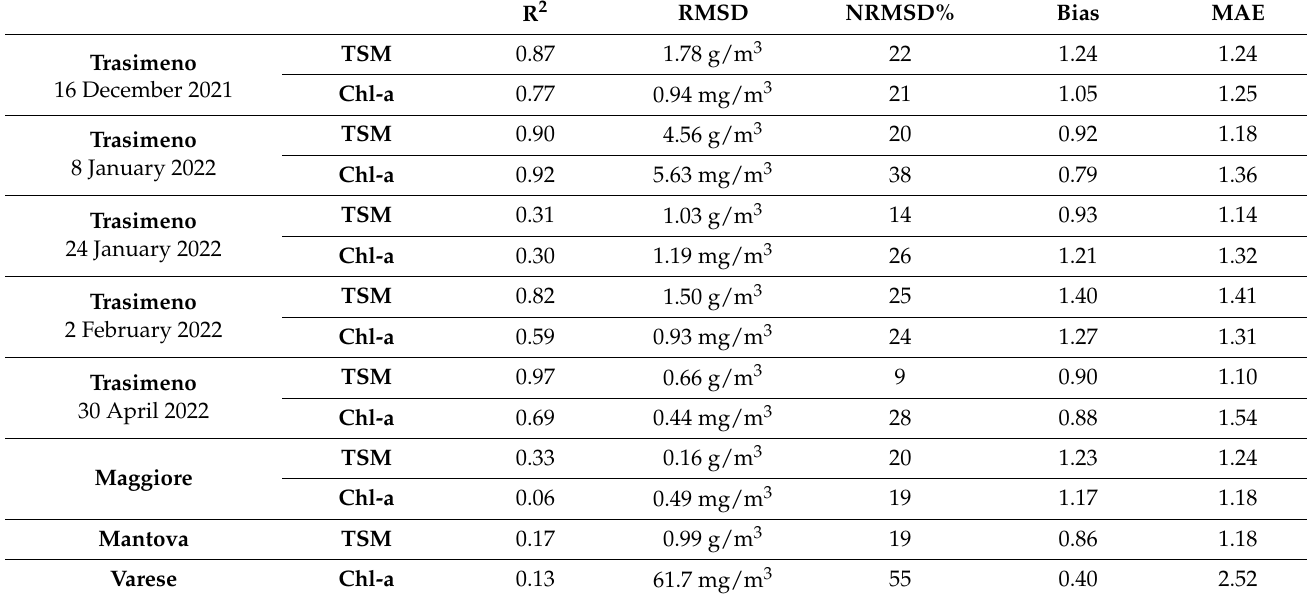
Figure 13. Pixel-by-pixel comparison of ( a ) TSM and ( b ) Chl-a maps derived from Landsat-9 vs. Sentinel-2 in Lake Trasimeno (16 December 2021). Table 3. Consistency analysis of TSM and Chl-a concentrations derived from Landsat-9 and Sentinel-2 via BOMBER in Italian lakes. R 2 RMSD NRMSD% Bias